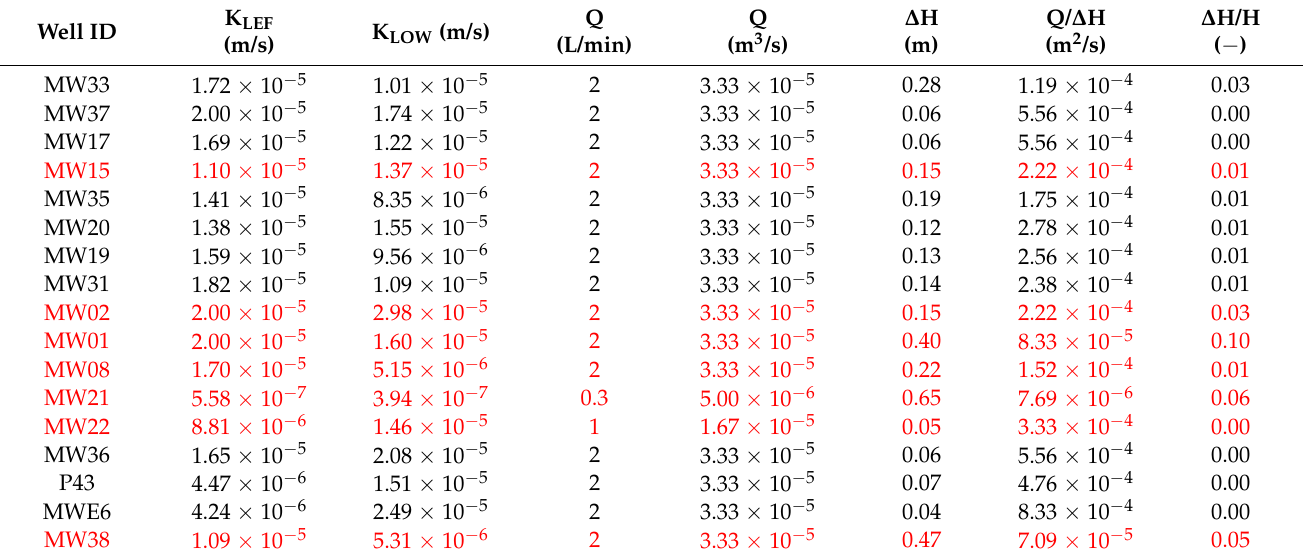
Table 3. Total K H results obtained for low-flow purging (K LOW ) and LeFranc (K LEF ) for monitoring wells. The red values are for confined conditions while the black values are for unconfined